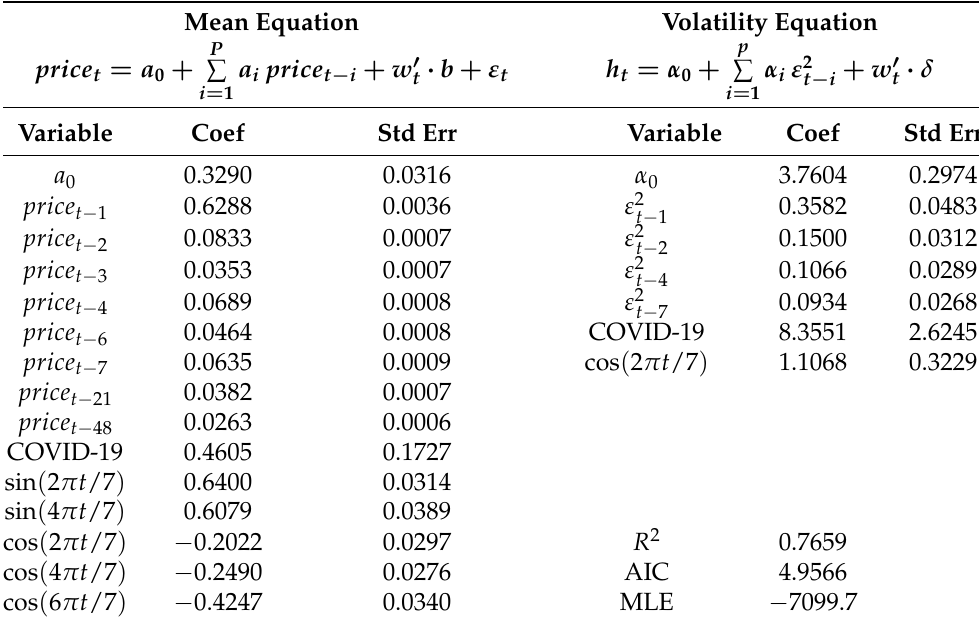
Table 2. Estimation results when assuming GED for standardized